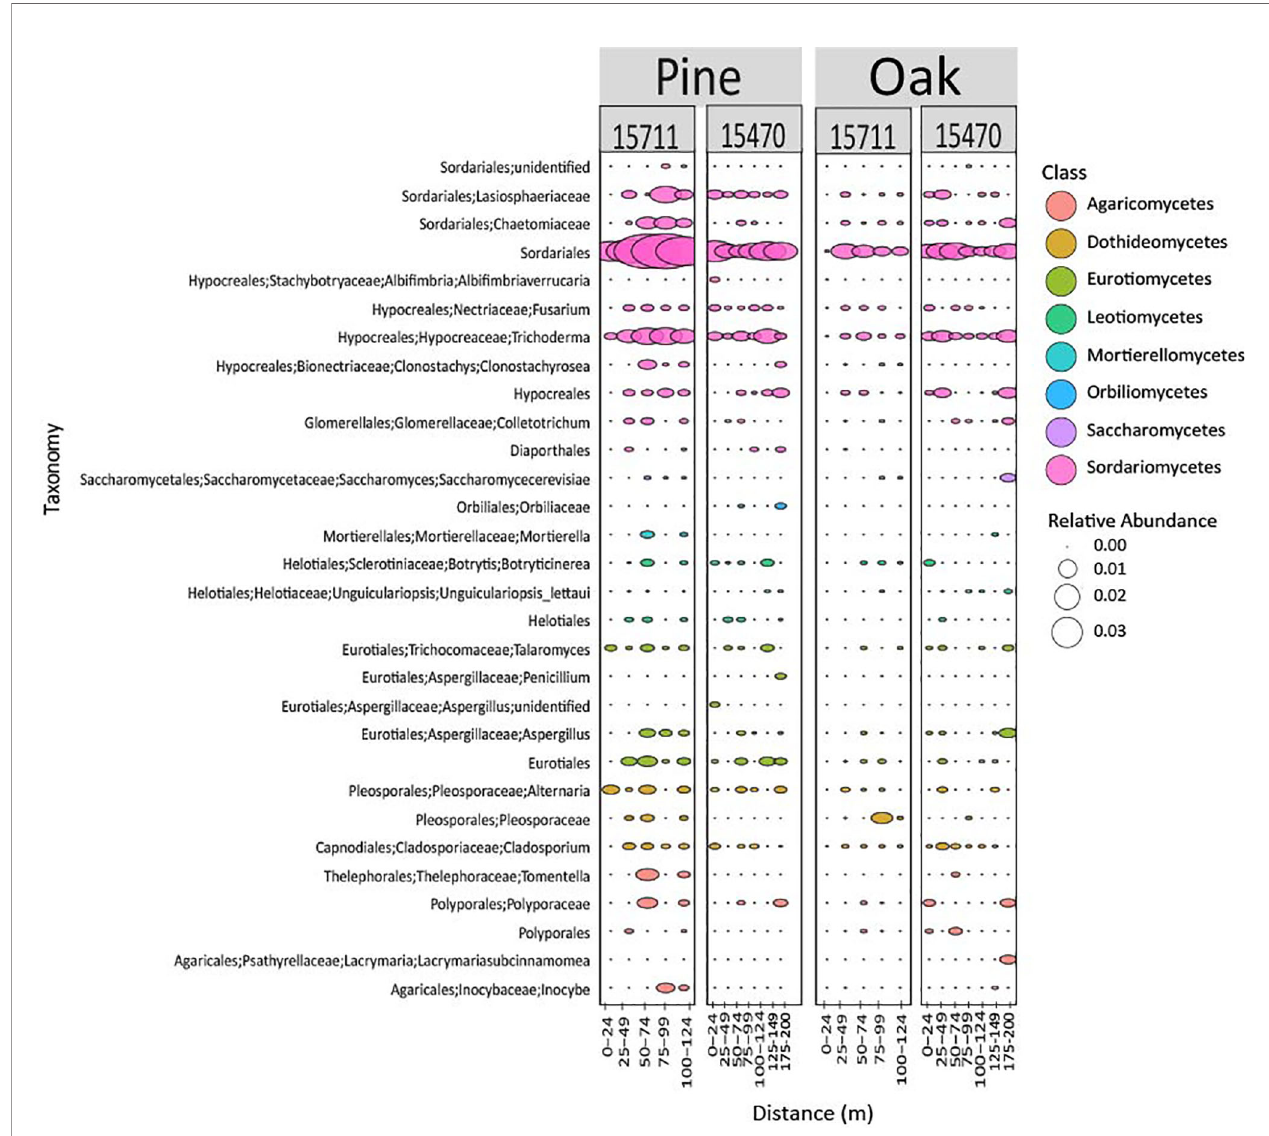
FIGURE 6 | Bubble plot representing the 30 most abundant fungal taxa from both sites and wood types. Samples are grouped in distance categories spanning 25